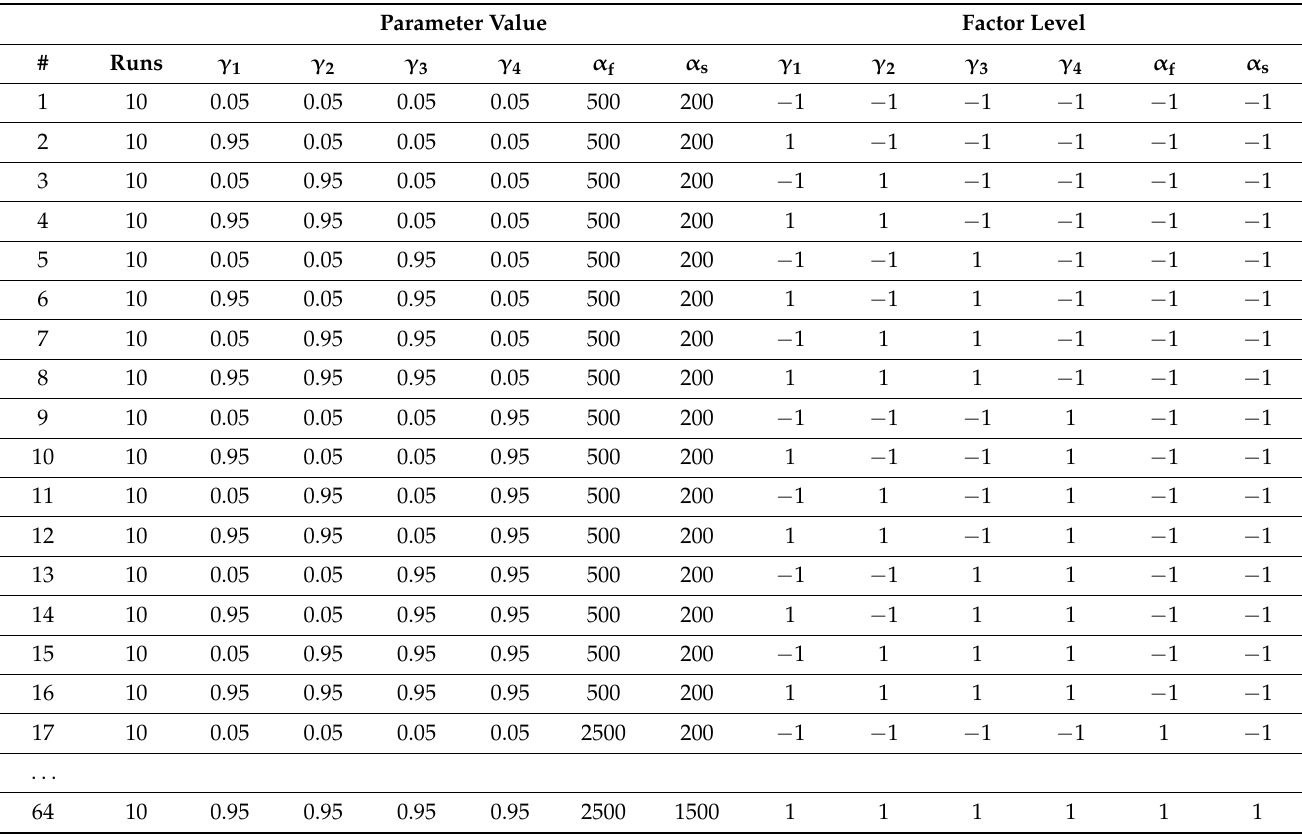
Table 4. Excerpt of the full factorial